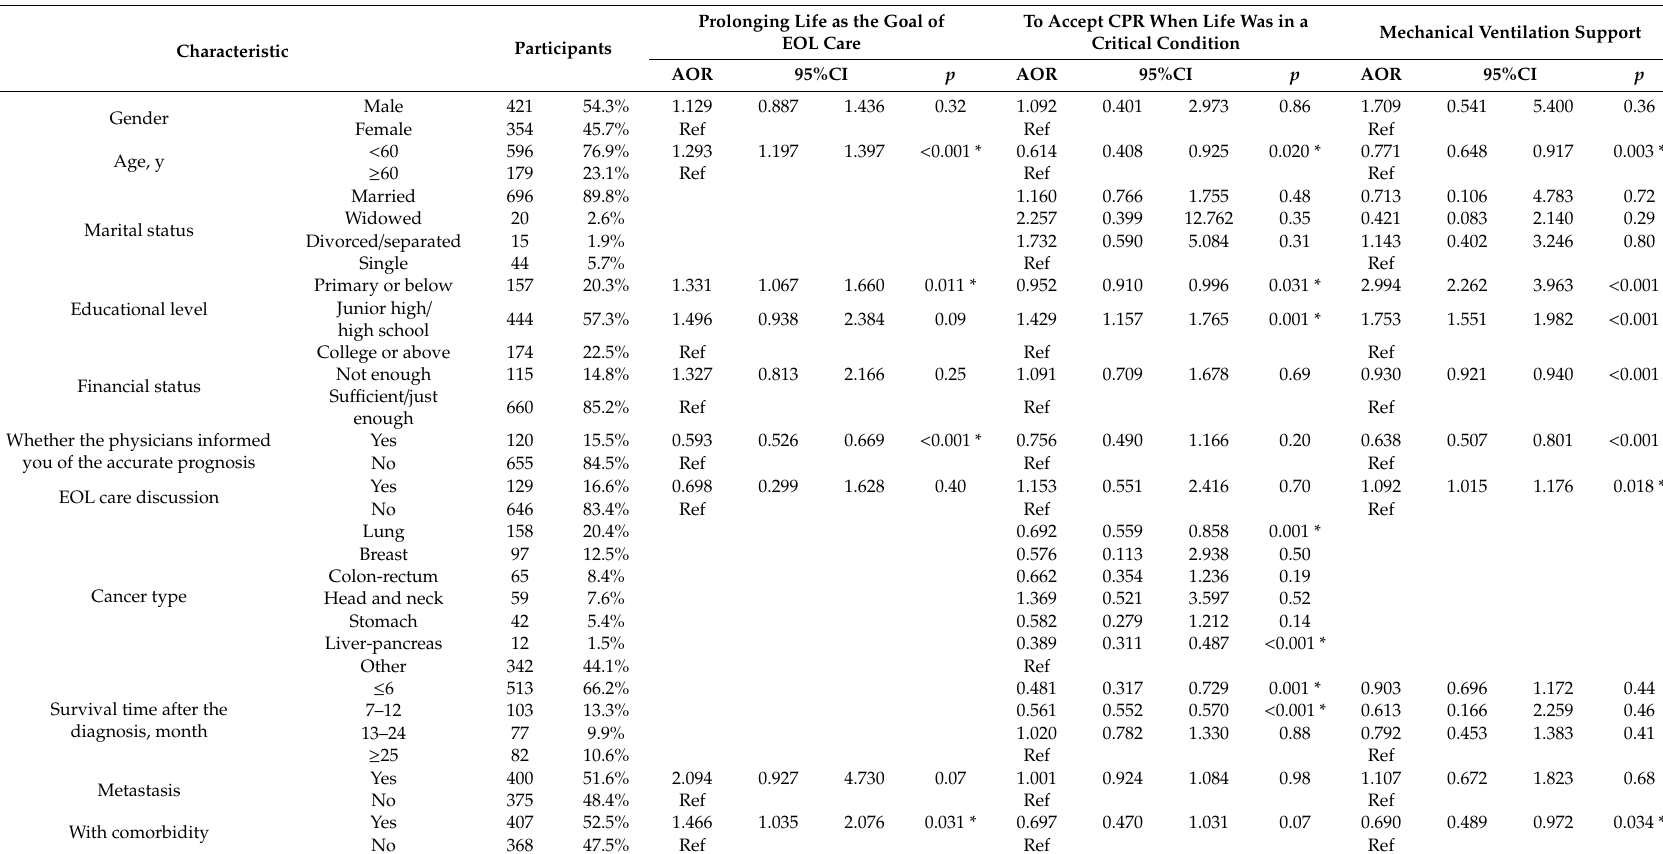
Table 2. Factors associated with Preferences for aggressive End of Life (EOL) Care: Prolonging Life as a Goal, Cardiopulmonary Resuscitation (CPR) When Life was in a Critical Condition, and Mechanical Ventilation